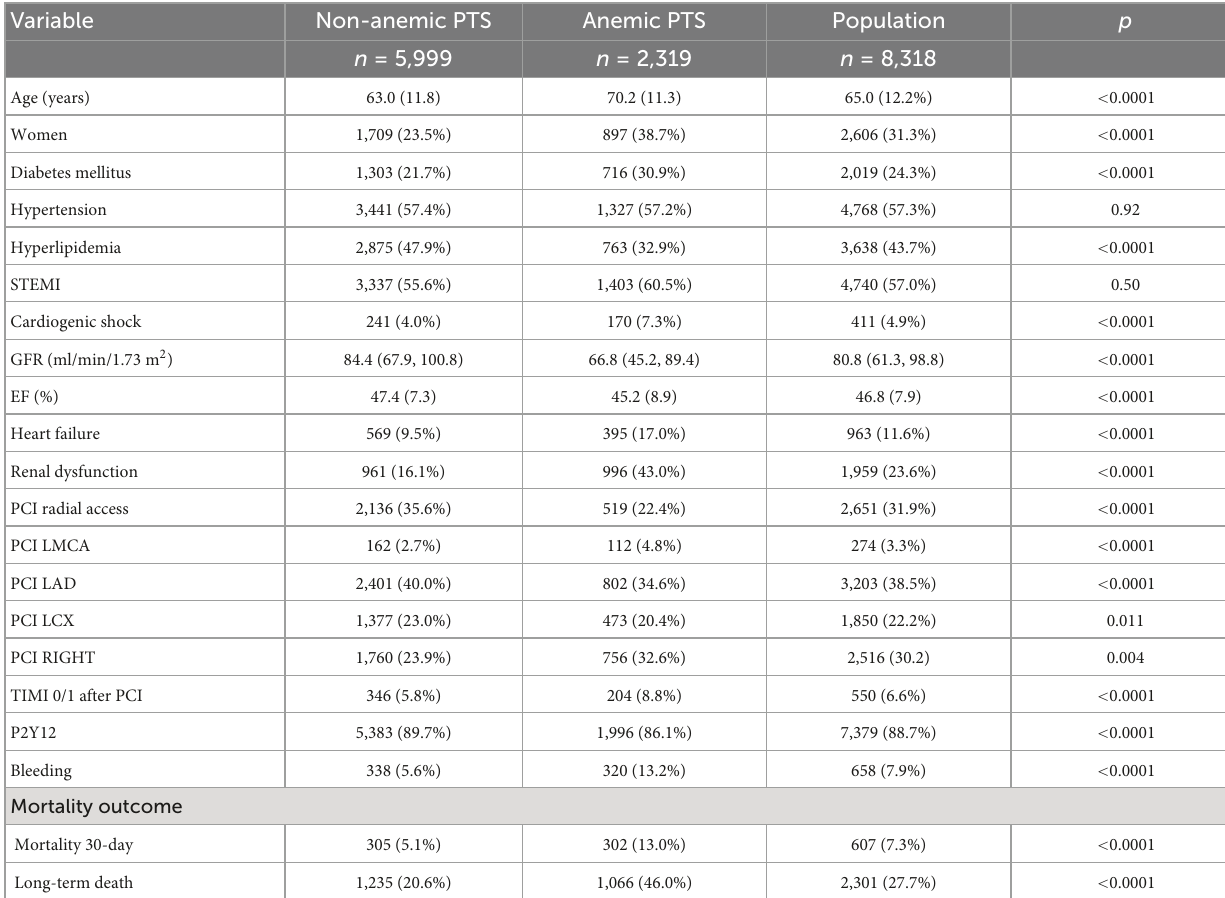
TABLE 1 Baseline and procedural characteristics of the study